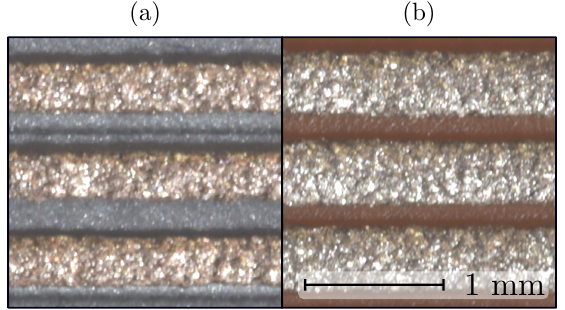
Figure 4. Extrusion rate E r influence: ( a ) E r = 90%, ( b ) E r = 130%.